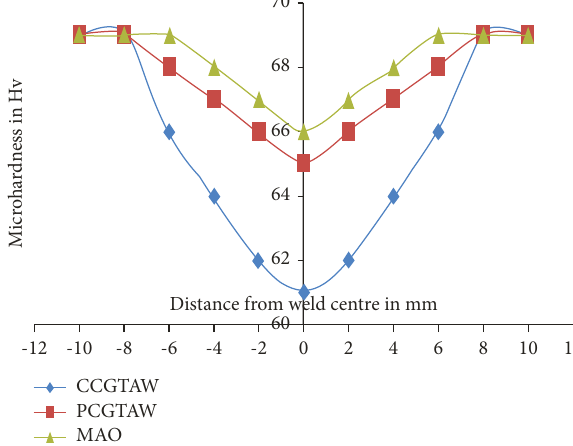
Figure 7: Fusion zone microhardness of the GTA weld.